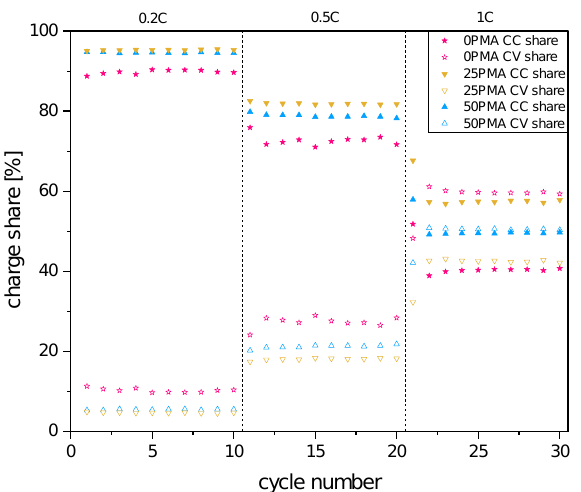
Figure 6. Galvanostatic (CC) and potentiostatic (CV) contributions to the specific charge capacities for 0.2C, 0.5C, and 1C. A plot including error bars is attached to the Appendix A (Figure